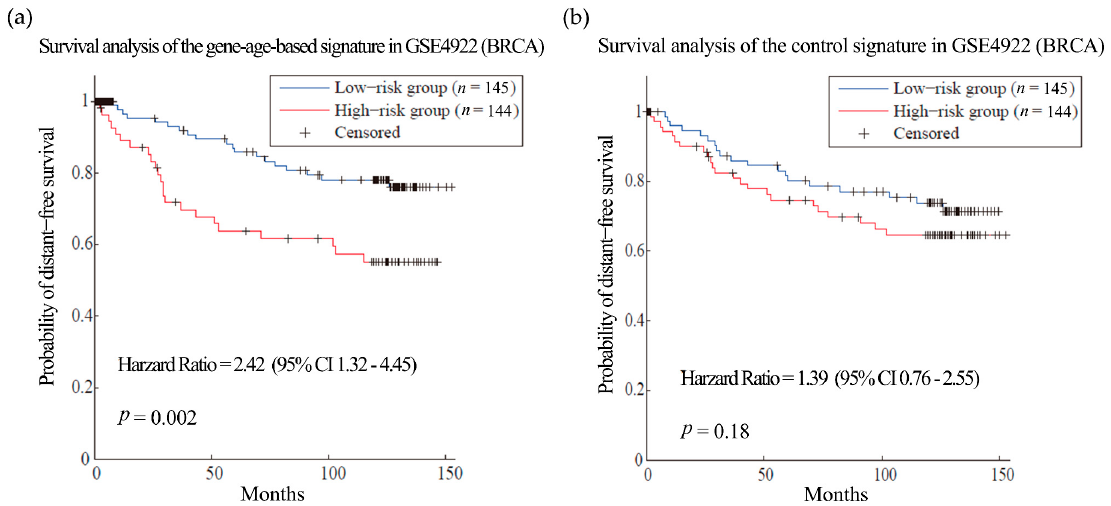
Figure 2. Survival analysis of the breast cancer (BRCA) dataset GSE4922. ( a ) and ( b ) are the predictions of the BRCA prognosis model using gene-age-based signatures and control signatures in independent test sets GSE4922 separately.